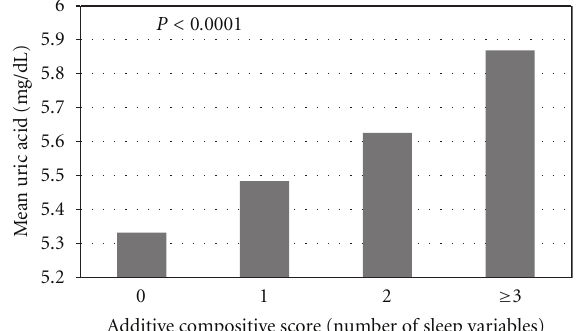
Figure 1: Multivariable-adjusted mean uric acid levels in relation to increasing additive composite score of sleep variables. Multivariable model adjusted for age (years), gender (male, female), education (below high school, high school, and above high school), smoking (never smoker, former smoker, and current smoker), and alcohol intake (absent,